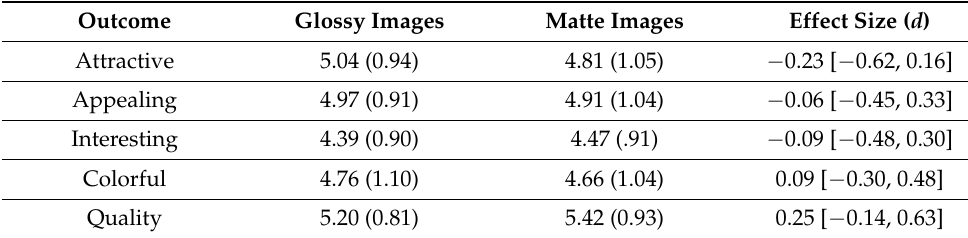
Table 1. Descriptive statistics.